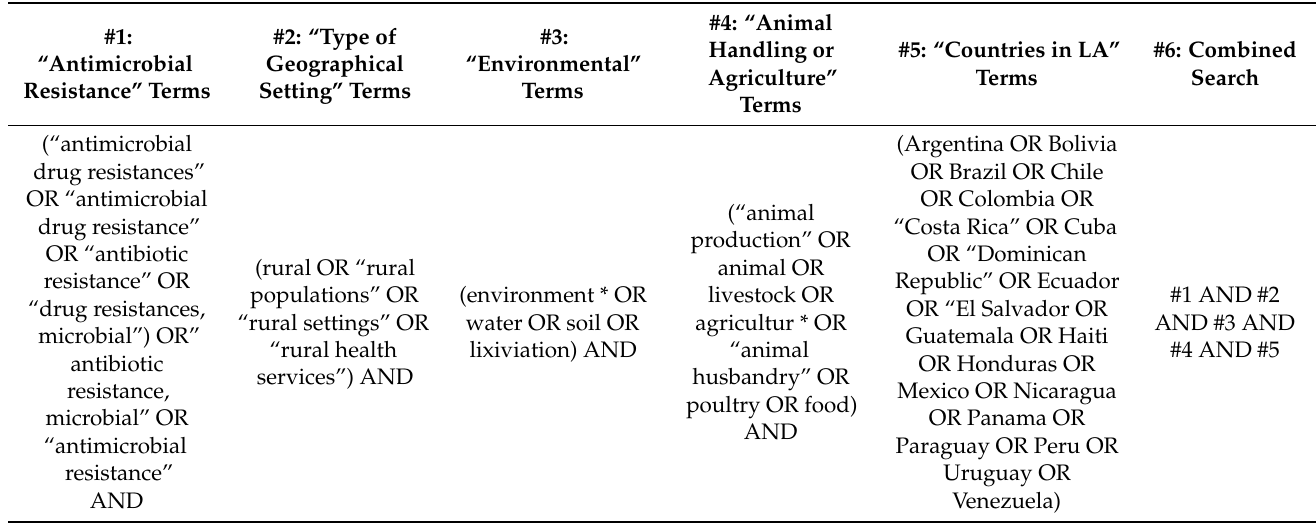
Table A1. Keywords (with synonyms) and syntax used for the literature